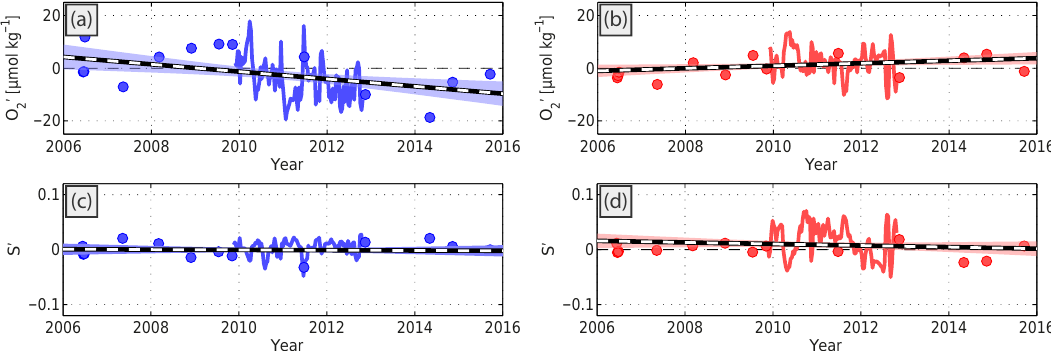
Figure 4. Oxygen ( a and b ) and salinity ( c and d ) anomaly time series from moored (solid line) and shipboard (dots) observations at 8 ◦ N, 23 ◦ W. Panels (a) and (c) show averages between 200 and 400m. Panels (b) and (d) show averages between 500 and 800m. Black dashed lines show respective trends from combined moored and shipboard observations: (a) − 13.9 ± 8.7µmolkg − 1 decade − 1 , (b) 4.8 ± 4.4µmolkg − 1 decade − 1 , (c) − 0.003 ± 0.020 decade − 1 and (d) − 0.014 ± 0.025 decade − 1